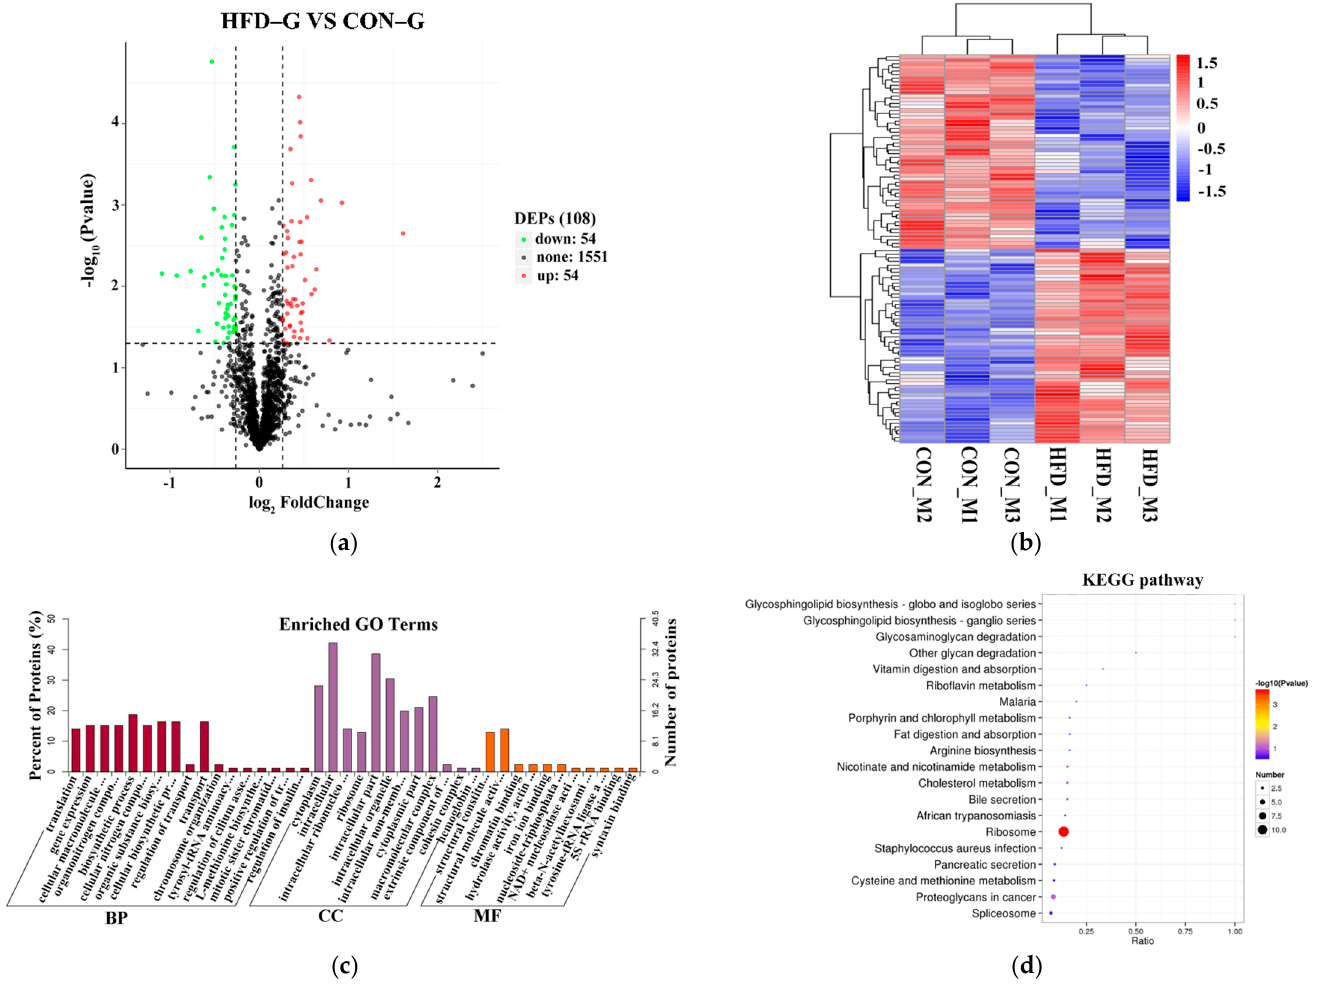
Figure 5. Screening and functional enrichment analysis of GO functions and KEGG signaling pathways of differentially expressed proteins in skeletal muscle samples from CON–G and HFD–G rabbits. ( a ) Colors in volcano map represent downregulated proteins (green dots), upregulated proteins (red dots), and nonsignificant proteins (black dots). ( b ) Colors in the heatmap represent changes in protein levels, from high (red) to low (blue). Left brackets represent clustering relationships among genes, and top brackets represent clustering relationships among samples. ( c ) In GO functional enrichment diagram, three colors represent biological processes (BP), cellular components (CC), and molecular functions (MF). Height of each column represents number of enriched genes. ( d ) In KEGG pathway enrichment diagram, color ranges from red (significant) to blue (nonsignificant), and circle size indicates number of enriched genes.